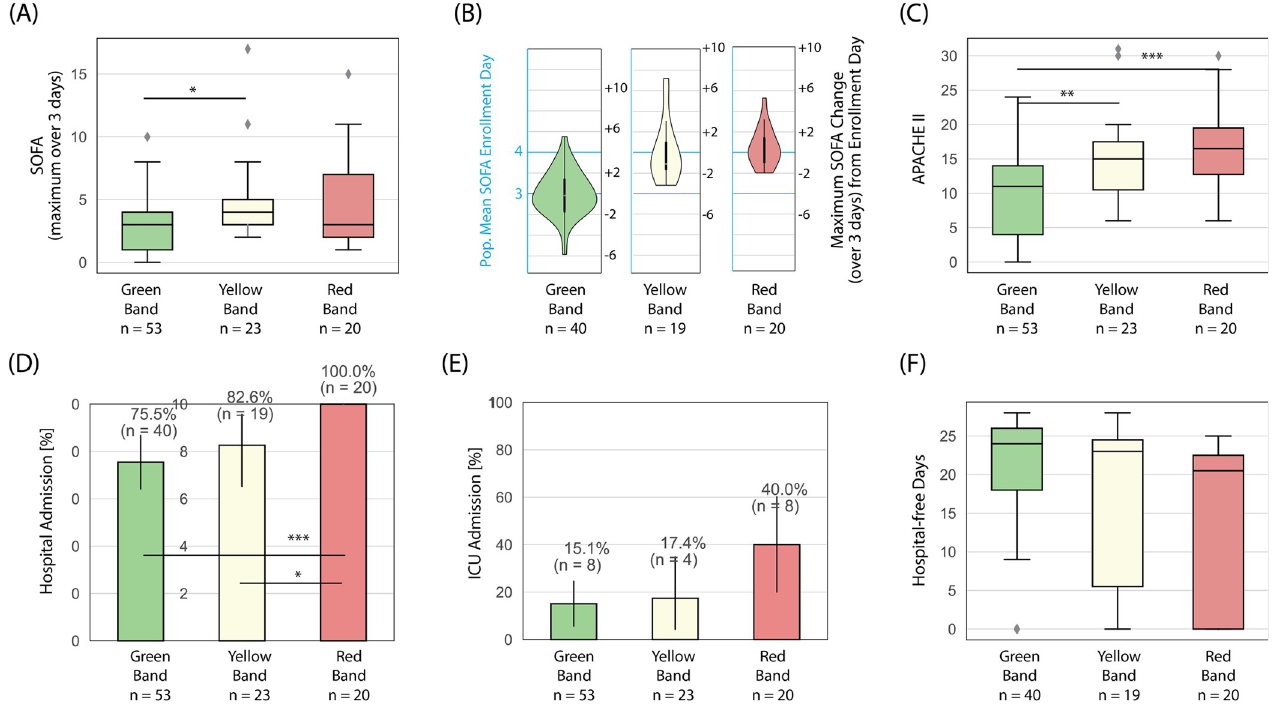
Fig 4. Trends in severity of illness scores and hospital utilization across ISI interpretation bands for SARS-CoV-2 positive subjects. (A) SOFA scores, maximum calculated over up to 3-days with the subject’s baseline over the prior 6-months subtracted; (B) maximum SOFA change over 3-days from day of presentation; (C) APACHE II scores calculated using worse values over 24 hours following presentation; (D) hospital admission; (E) admission to the ICU; (F) hospital-free days in those admitted to the hospital, calculated as 28 –hospital length of stay, with zero for in-hospital mortality. Box plots: lines in the boxes, medians; the box ends, interquartile ranges (IQR); whiskers, 1.5x IQR; diamonds, outliers. Bar graphs: Bars, percentages; error pars, 95% confidence intervals. p-values were obtained from an unpaired two-sample Welch’s t-test (except for hospital free days, where the Mann–Whitney U was due to the non-normal distribution), with the null hypothesis that the mean of the two samples are equal. p-values reported as � p < 0.05, �� p < 0.01, and ��� p < 0.001.